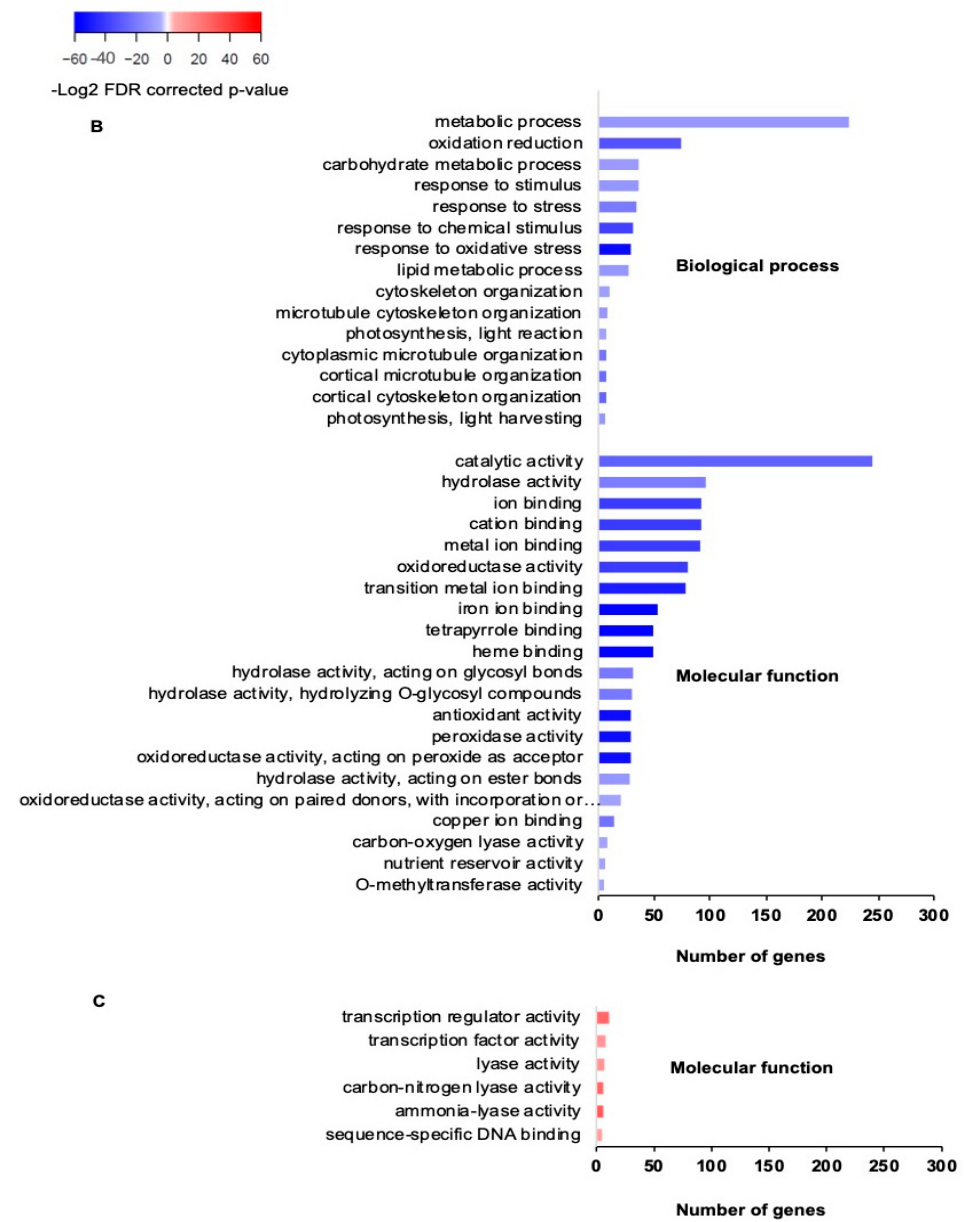
Figure 4. Enriched gene ontology (GO) terms in the two wheat varieties in response to wheat curl mites. GO terms were significantly upregulated in the resistant wheat ( A ), downregulated in the resistant wheat ( B ), and upregulated in the susceptible wheat ( C ). No significantly downregulated enriched GO terms were identified in the susceptible variety. GO terms (FDR corrected p -value < 0.05) with significant numbers of upregulated or downregulated genes were identified by contrasting gene expression in response to aphid herbivory and control (aphid-free plants). DEGs were then grouped into biological process, molecular function, and cellular component categories. The colors of the bars refer to the –log2-corrected p -values of the corresponding GO terms. The red bars indicate the enriched GO terms in the upregulated genes, and the blue bars indicate the enriched GO terms in downregulated genes. The darker the color, the higher the statistical signifi- cance.